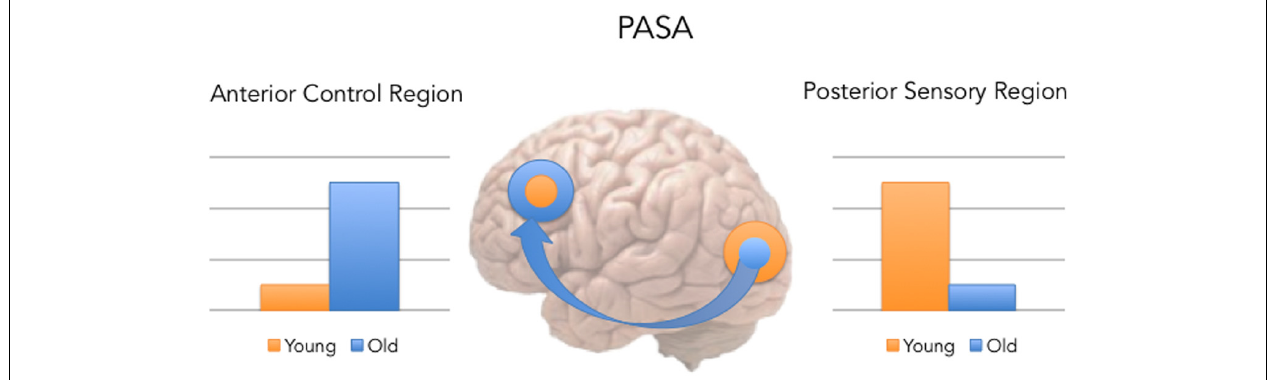
FIGURE 1 | Posterior-to-anterior shift in aging (PASA) predicts that with age comes a shift, such that older participants show greater activity in the left dorsolateral prefrontal cortex (DLPFC) and less activity in the left visual cortex during memory tasks, while younger adults show the reverse pattern.